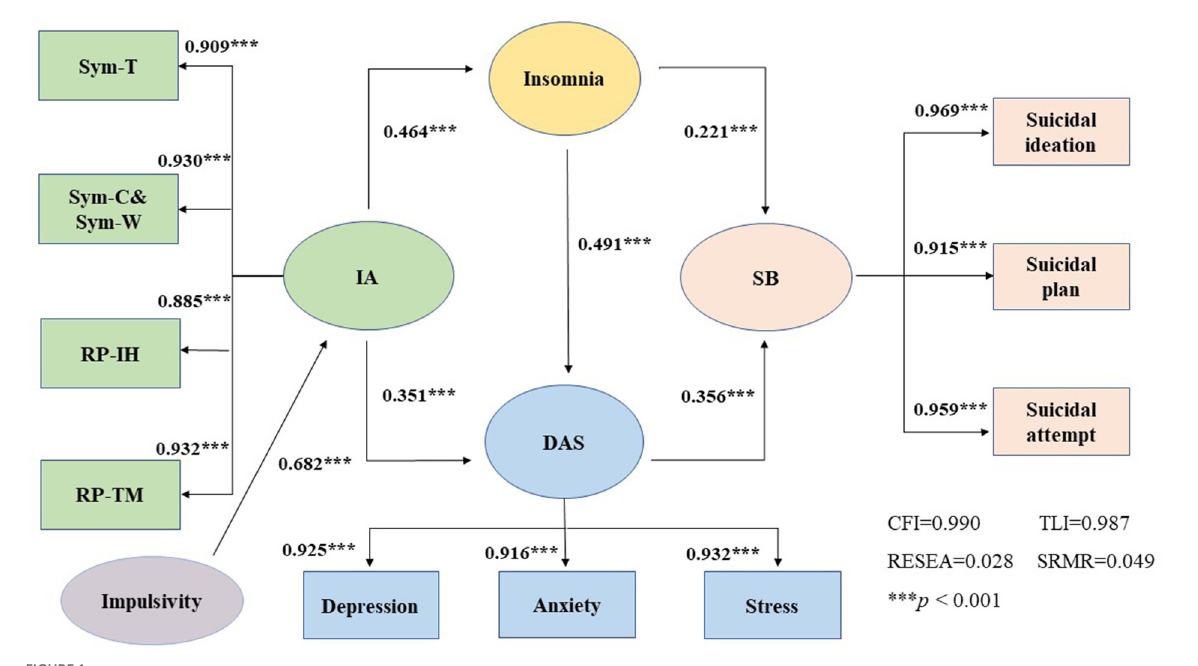
FIGURE1 The SEM for the association between Internet addiction and suicidal behavior with insomnia, depression, anxiety, stress as mediating variables among Chinese vocational high school students (adjusted for age and sex as covariates). Sym-T, Internet addiction tolerance symptoms; Sym-C and Sym-W, compulsive Internet use and Internet addiction withdrawal symptoms; RP-IH, interpersonal and health problems; RP-TM, time management problems. IA, Internet addiction; DAS, depression, anxiety, and stress; SB, suicidal behavior. *** p <